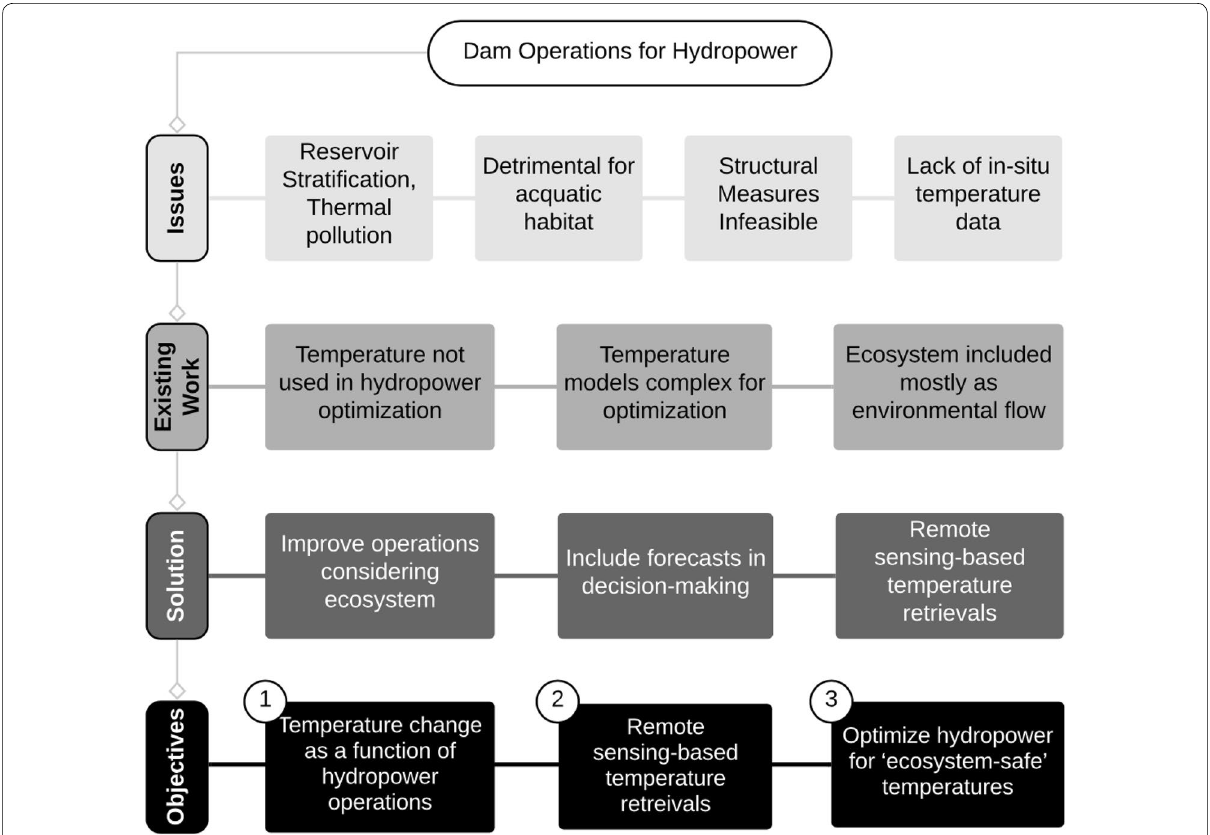
Fig. 1 Pertinent issues with the current state of hydropower operations, brief summary of the existing literature and proposed solutions leading to the study